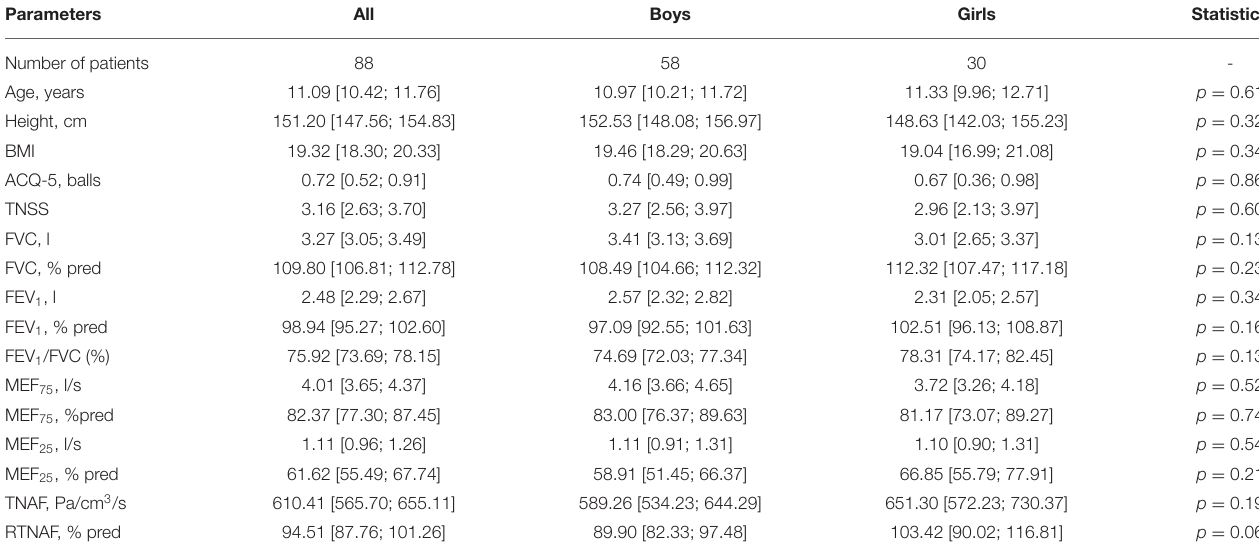
TABLE 1 | Clinical and functional characteristics of examined children with BA.